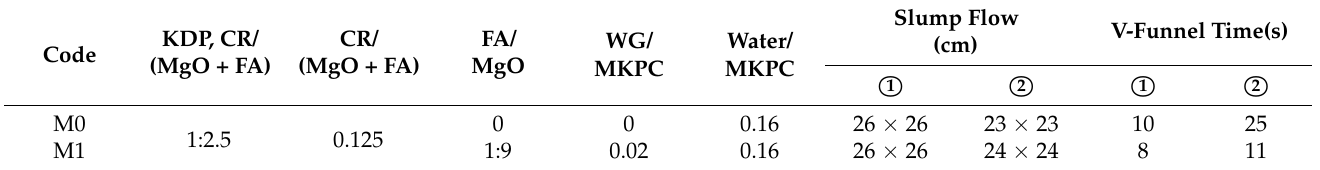
Table 1. Mix proportions of MKPC paste (wt%).